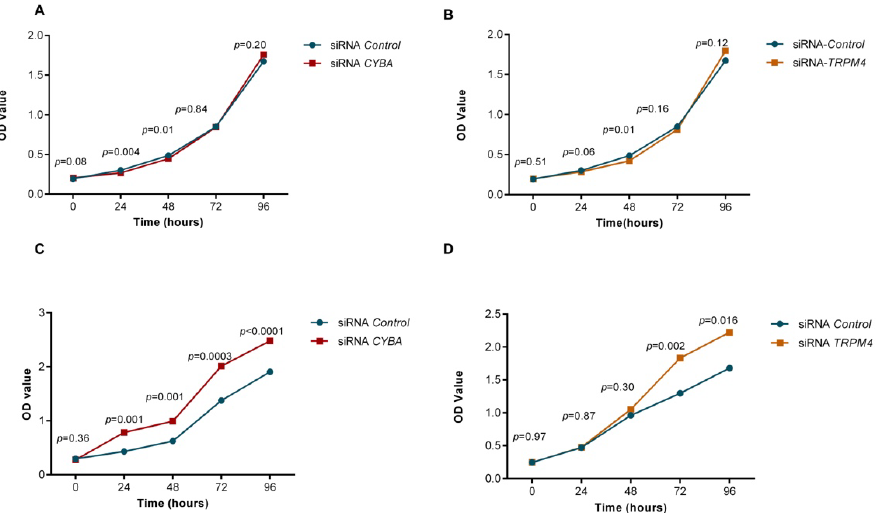
Figure 3. Effect of CYBA or TRPM4 knockdown on cell proliferation of LS174T and HT29 cells measured by CCK-8 cell assay. (A) LS174T cells transfected with siRNA-CYBA ( A ) or siRNA-TRPM4 ( B ) showed similar proliferation compared to siRNA-control transfected cells. HT29 cells transfected with siRNA-CYBA ( C ) or siRNA-TRPM4 ( D ) showed a significant increase in proliferation compared to siRNA-control transfected cells.